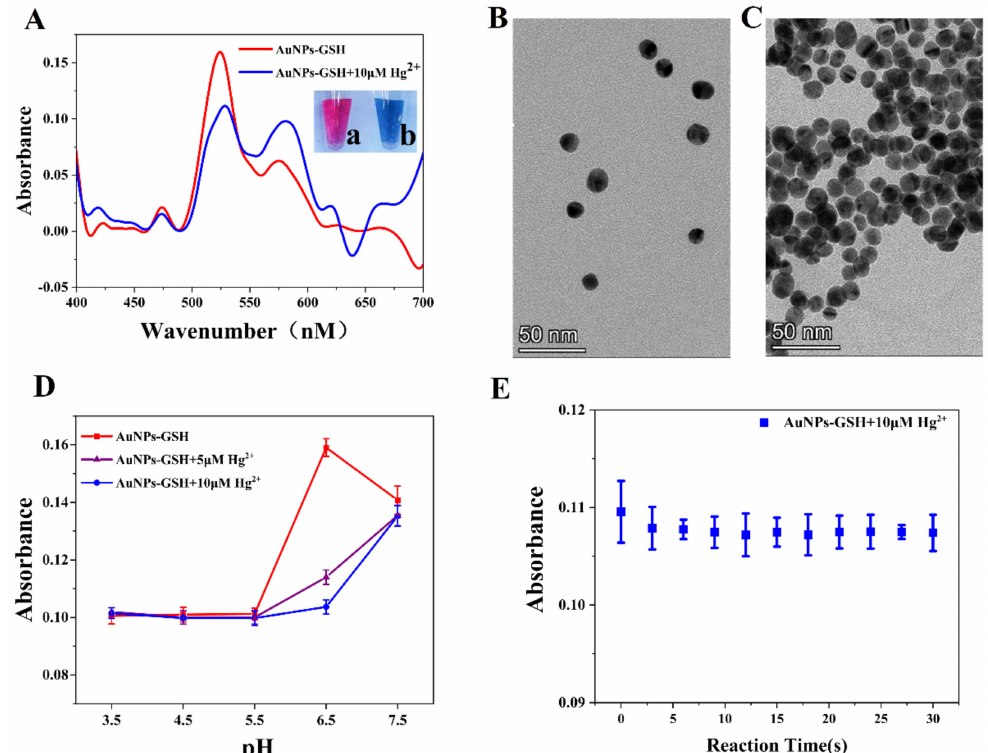
Figure 4. ( A ) Characterization of the absorption spectra of the AuNPs − GSH solution using the proposed sensor (a) without Hg 2+ and (b) with 10 µ M of Hg 2+ ; ( B , C ) TEM images of the AuNPs − GSH solution before and after addition of Hg 2+ ; ( D ) absorbance analysis results before and after addition of Hg 2+ to the AuNPs − GSH solution under different acid − base environmental conditions; ( E ) changes in absorbance over time after addition of Hg 2+ to the AuNPs − GSH